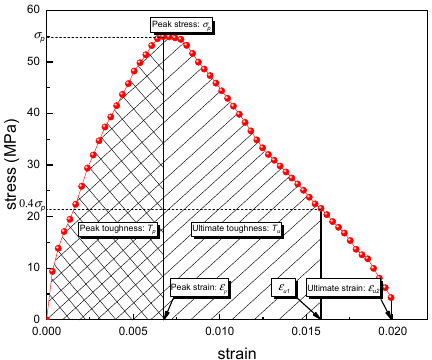
Figure 10. Dynamic characteristic parameters in the stress–strain curve of the SHPB test.